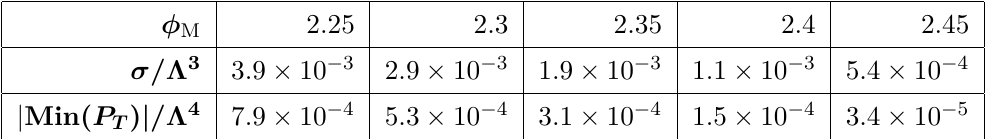
Table 3 . Surface tension in equilibrium and the absolute value of the minima of the transverse pressure for each